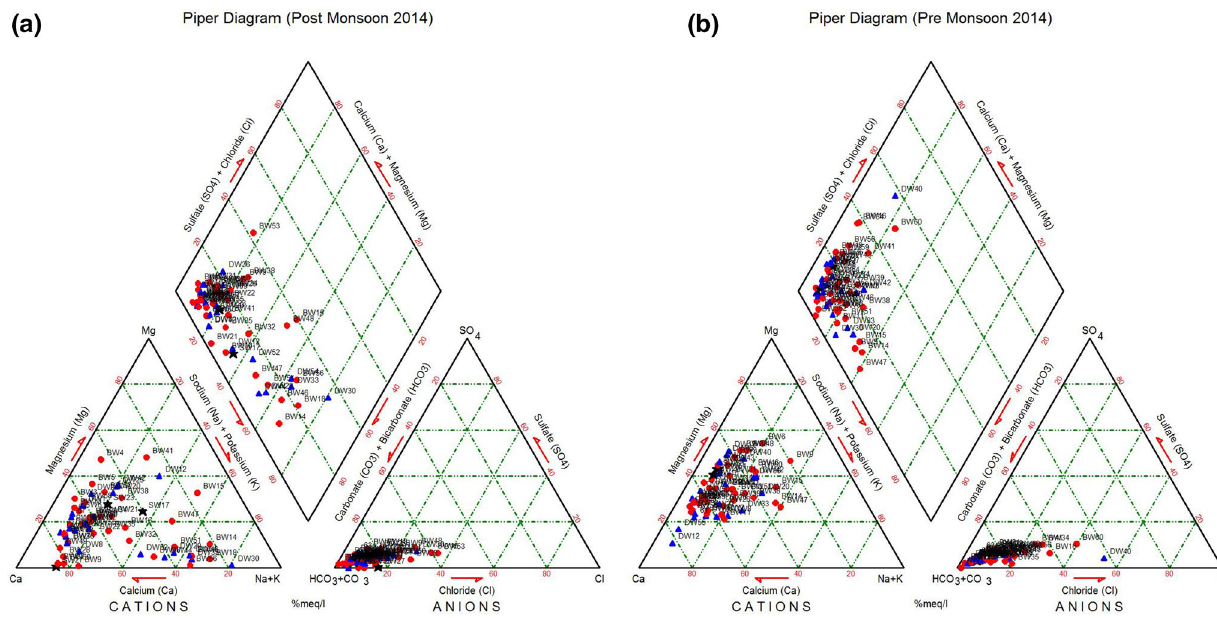
Fig. 6 a Hydrochemical facies of the groundwater samples in POM 2014. b Hydrochemical facies of the groundwater samples in PRM 2015